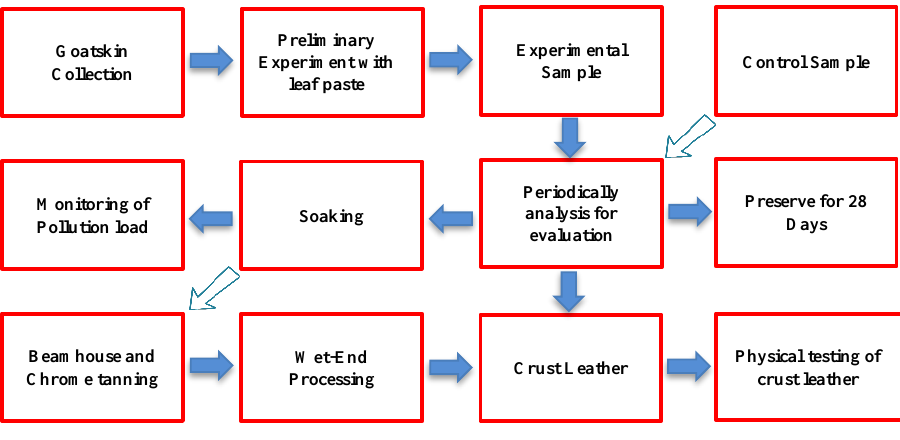
Figure 4. Flow chart of the proposed